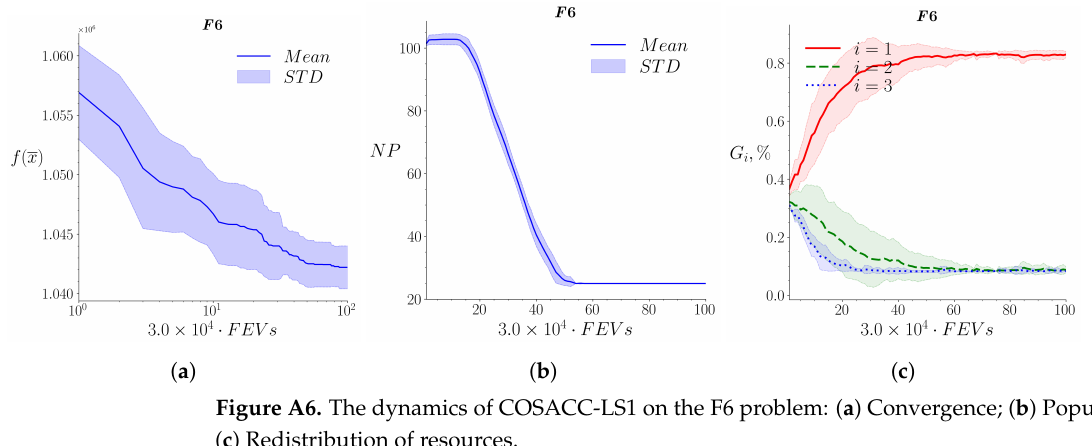
Figure A6. The dynamics of COSACC-LS1 on the F6 problem: ( a ) Convergence; ( b ) Population size; ( c ) Redistribution of resources.